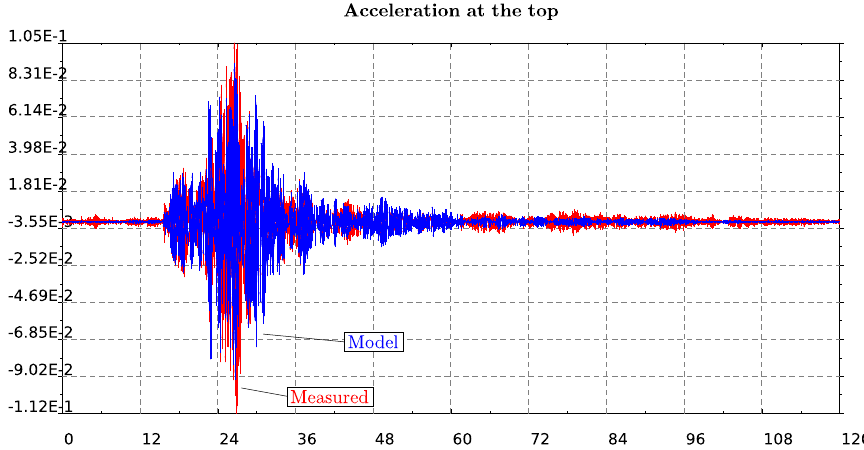
Figure 13. Response of top level acceleration for the East–West model (top plot) and for the North–South (bottom plot), respectively. Both recorded motion (red) and computed by the model (blue) are presented.